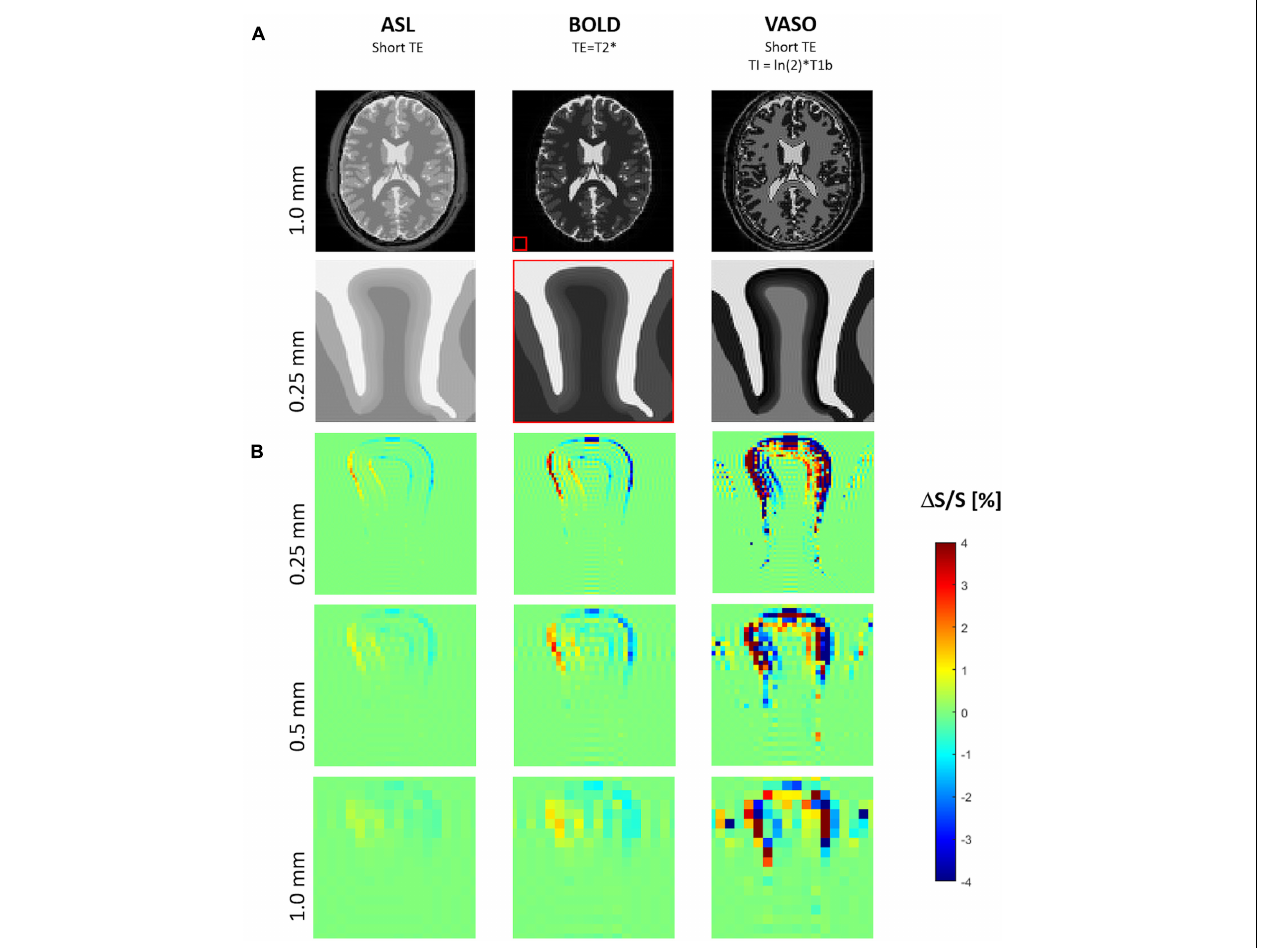
FIGURE 7 | (A) Simulated MR images for three typical functional magnetic resonance imaging (fMRI) sequence types with proton density contrast (e.g., ASL), BOLD contrast, VASO contrast. The biomechanically modeled gyrus is shown below the corresponding image of a digital brain phantom of MRiLab for illustrating the typical whole-brain MR contrasts seen at 7 Tesla and the relative spatial dimensions (red box). (B) Maps of signal change due to tissue displacement following a 2% increase of both volume and stiffness of the activated layer segment (see also Figure 1B ) at three different resolutions, i.e., voxel sizes of 1, 0.5, and 0.25